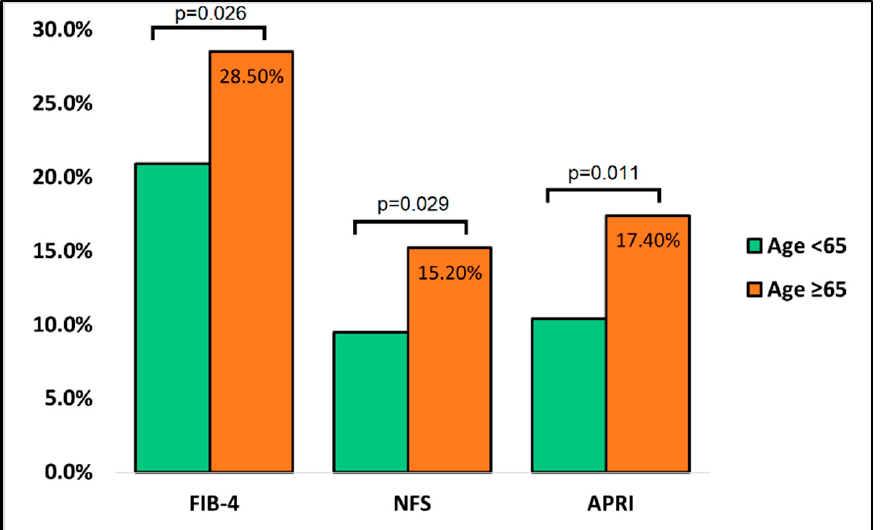
Figure 2. Comparison of liver fibrosis scores between cases and controls at discharge. Table 5. Comparison of liver studies at admission between survivors and deceased elderly with